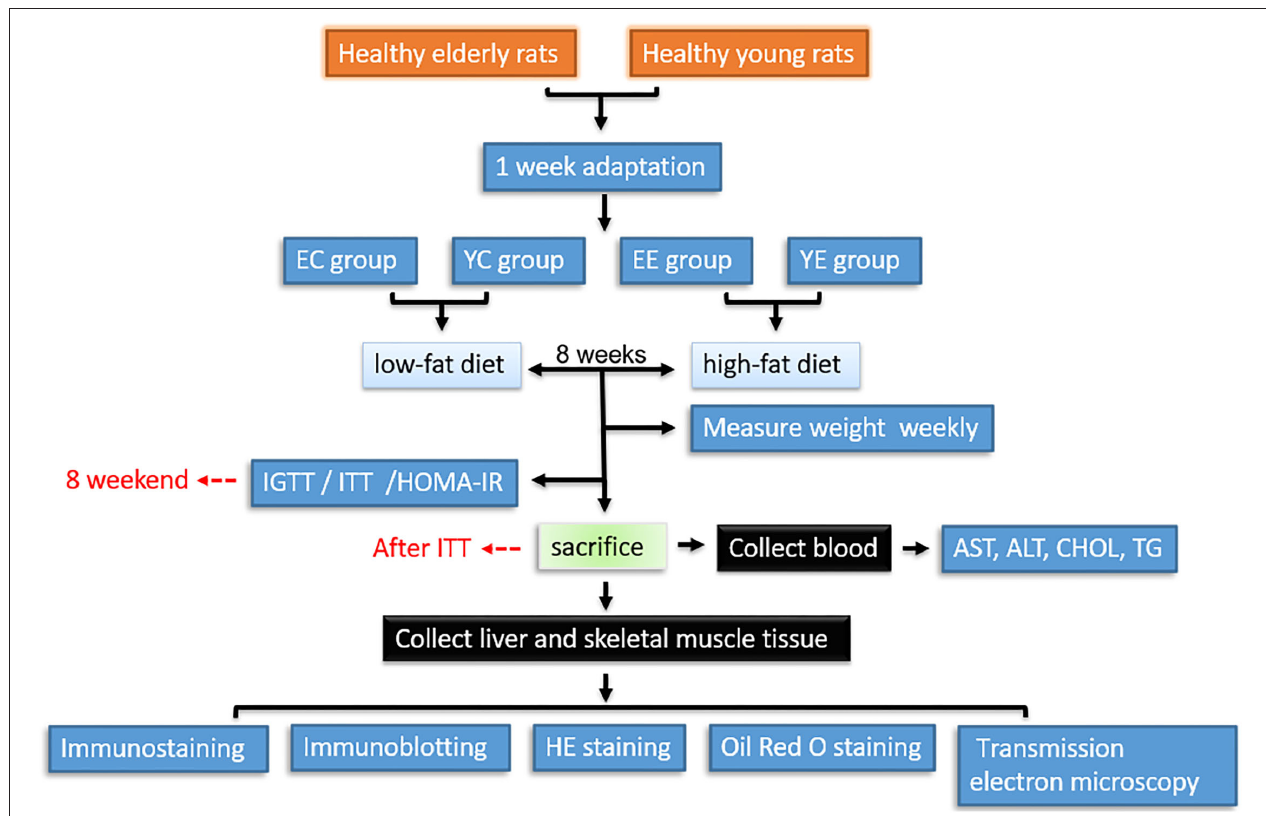
FIGURE 1 | Workflow for hematology, histopathological, and proteomic analysis of tissues from insulin resistance rats. YC, young control group; YE, young experimental group; EC, elderly control group; EE, elderly experimental